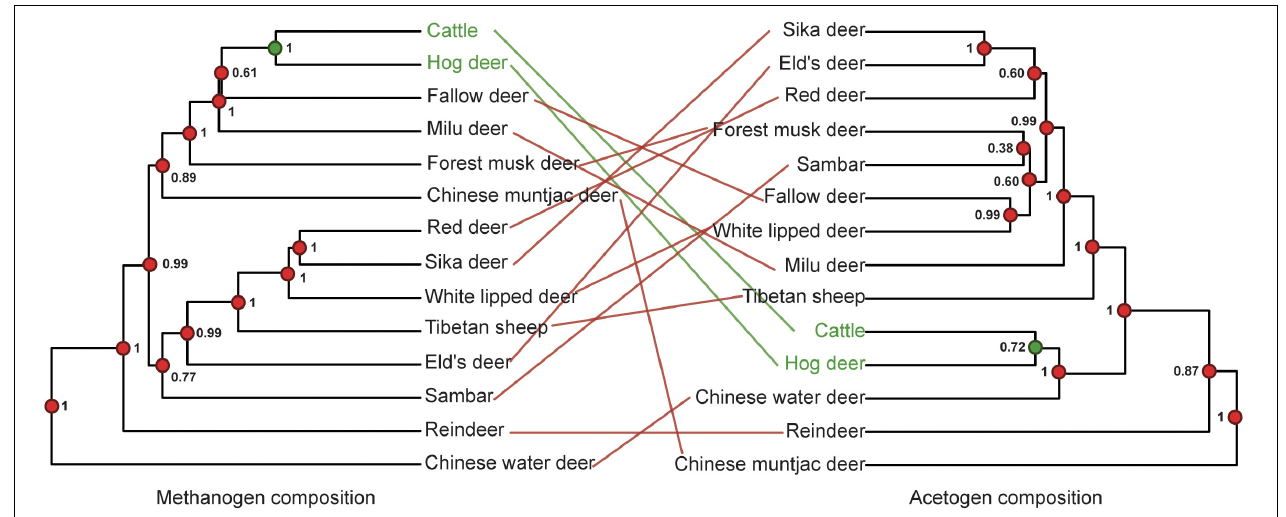
FIGURE 4 | Co-occurrence analysis of methanogens and acetogens. Node dot color indicates whether the node contains the same (green) or a different (red) combination of taxa as the paired tree. Node values indicate posterior probabilities in the host phylogeny and node support based on 1,000 iterations of UniFrac distances in microbiota composition dendrograms. The color of lines connecting the taxa indicates whether taxa are located in identical (green) or different (red) subtrees in both